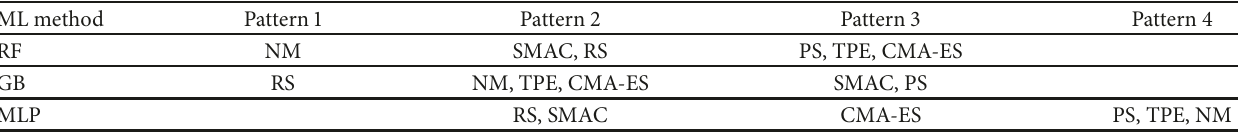
Table 8: Patterns of profit.